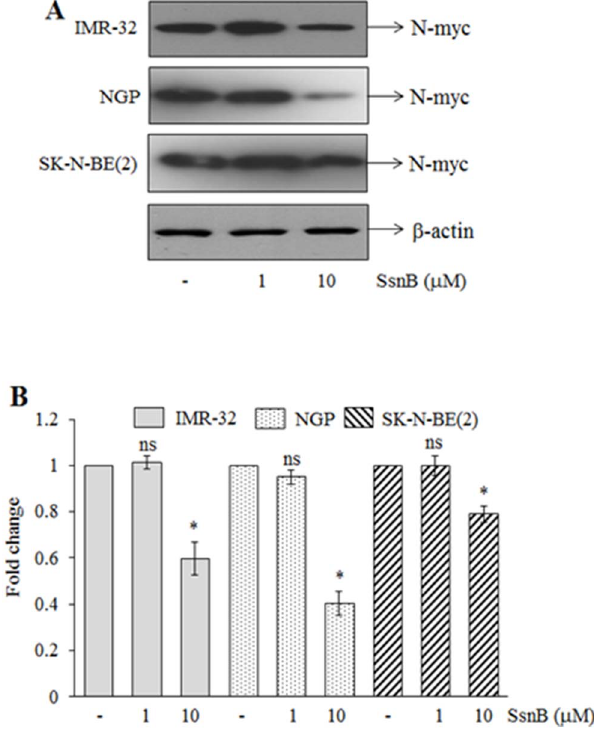
Figure 4. N-myc protein level in IMR-32, NGP and SK-N-BE(2) cells. (A) Representative Western blots for N-myc protein in total cell extract prepared from IMR-32, NGP and SK-N-BE(2) cells treated with or without SsnB (1 m M or 10 m M) for 2 days, 3 days or 4 days, respectively. b -actin was used to check loading differences. ( B ) Bar diagram represents the fold change in N-myc protein signals as measured by imageJ programme. Bar represents mean and S.D. of three independent experiments and * p , 0.05, SsnB 10 m M vs control; ns = nonsignificant vs control.